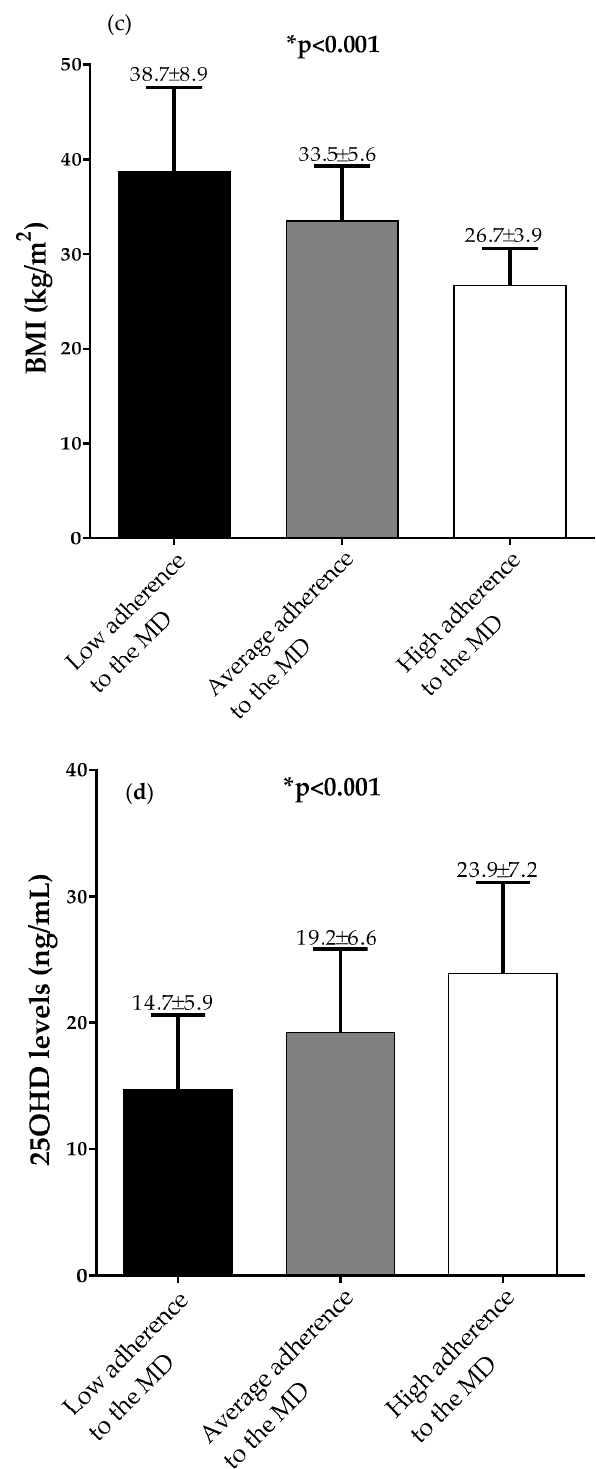
Figure 1. BMIs ( a ) and PREDIMED scores ( b ) across 25OHD categories, and BMIs ( c ) and 25OHD levels ( d ) across PREDIMED categories, in males. A * p value denotes a significant difference ( p < 0.05).